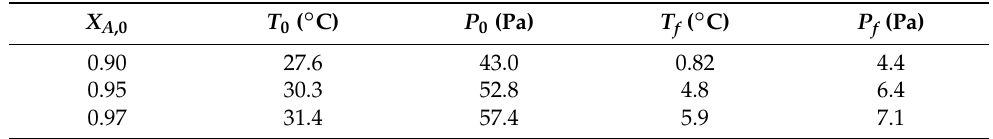
Table 4. The initial and final three-phase transformation conditions for the formation of m -chlorophenol solid product during the batch SC